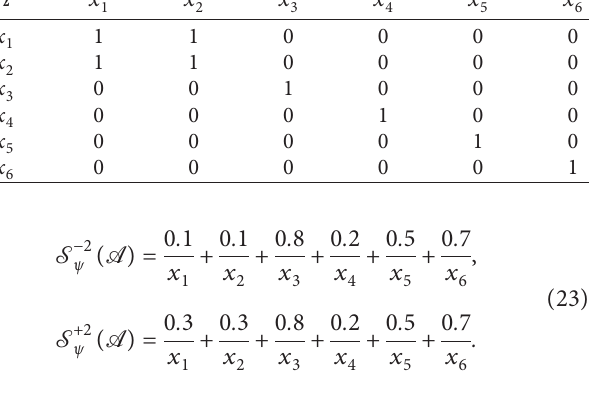
Table 3: Table for D 2